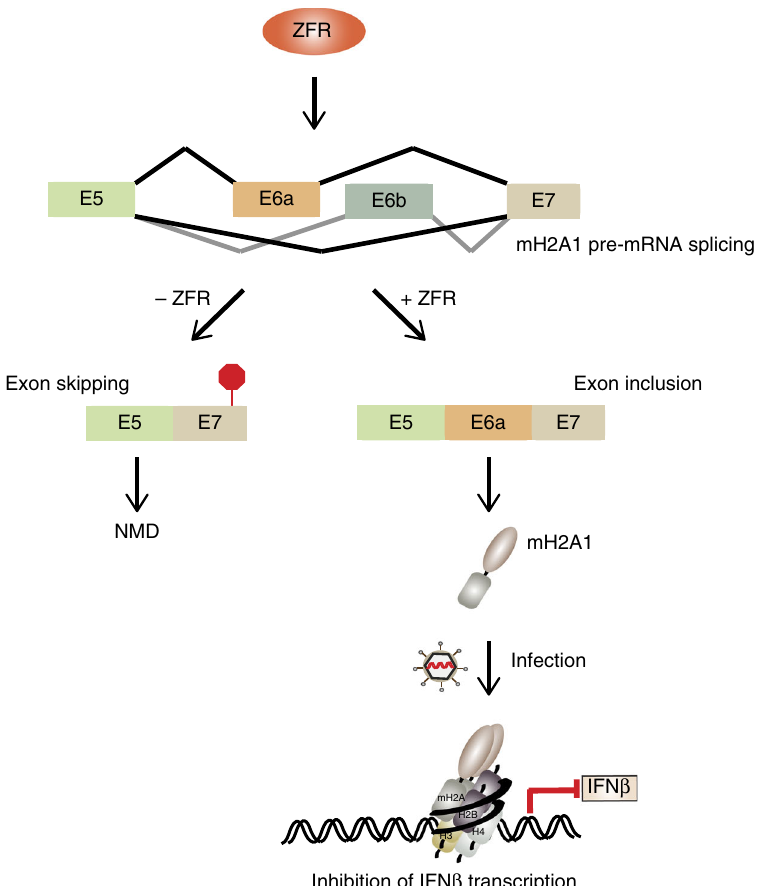
Fig. 7 Model for ZFR-mediated regulation of IFN β . ZFR is required for productive splicing of mH2A1 . In the absence of ZFR, mH2A1 pre-mRNA is mis-spliced and resulting transcript is degraded by NMD. In the presence of ZFR, mH2A1 protein is expressed and directly represses the IFNB1